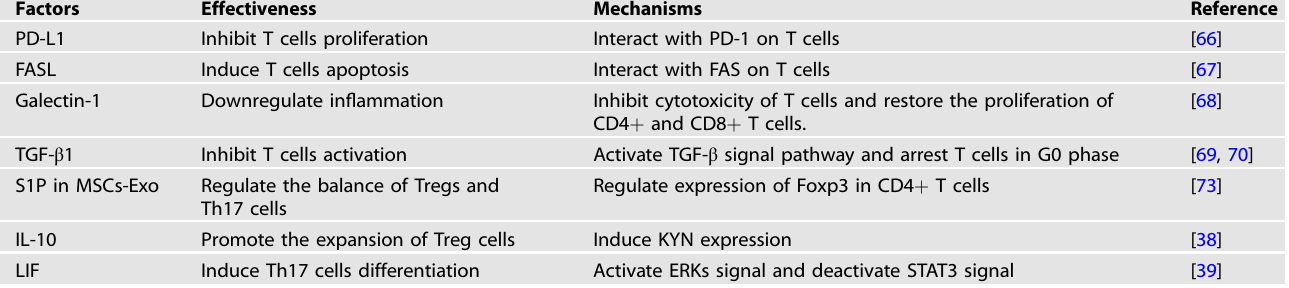
Table 3. Paracrine effectors of MSCs in the regulation of T cells and NK